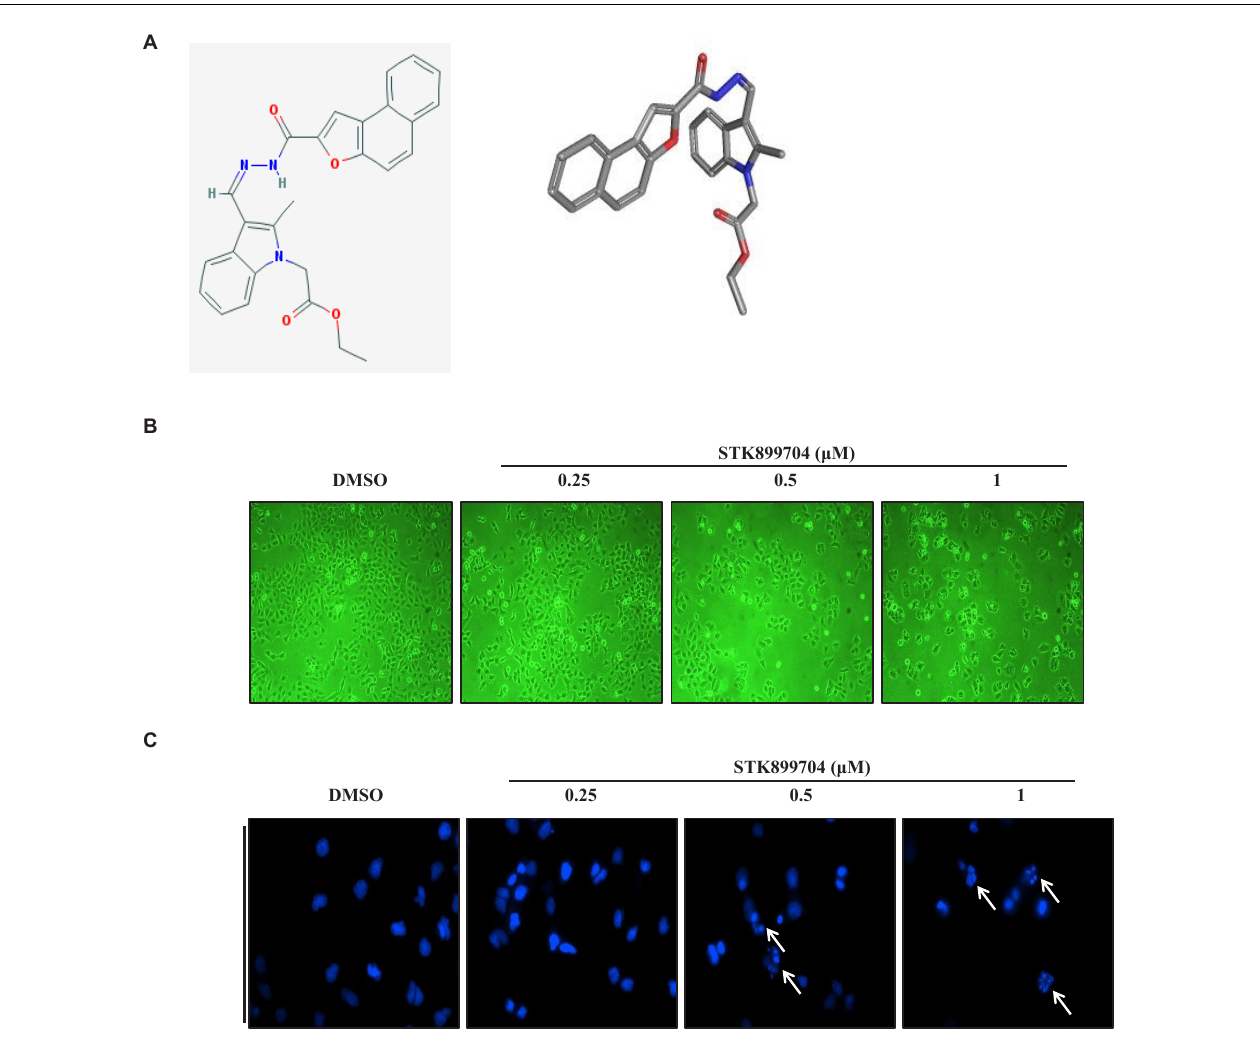
FIGURE 1 | Cytotoxic effects of STK899704 on A549 cells. (A) Chemical structure of STK899704. (B) Micrographs of A549 cells treated with the indicated concentrations of STK899704. (C) STK899704-induced changes in nuclear morphology were determined by performing 4 (cid:48) ,6-diamidino-2-phenylindole (DAPI) staining. Micrographs were taken using a phase-contrast microscope (magnification, 100 × ). The white arrows indicate cells showing mitotic